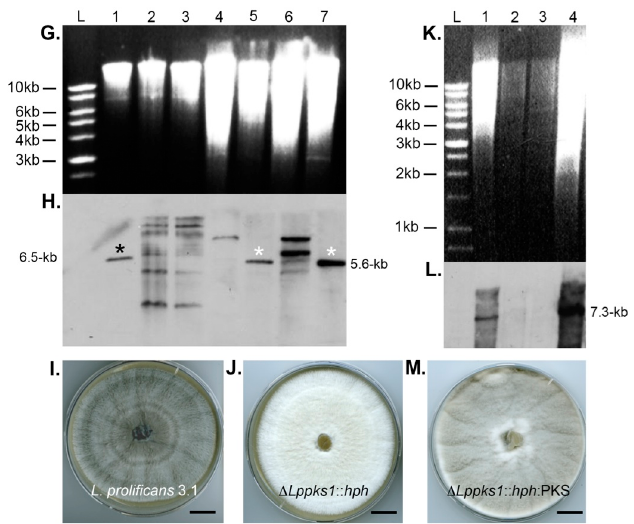
Figure 1. Southern blot analysis of targeted scytalone dehydratase 1 ( SCD1 ) and polyketide synthase ( PKS1 ) gene replacements and PKS1 complementation and resultant phenotypes of Δ Lpscd1 :: hph ,